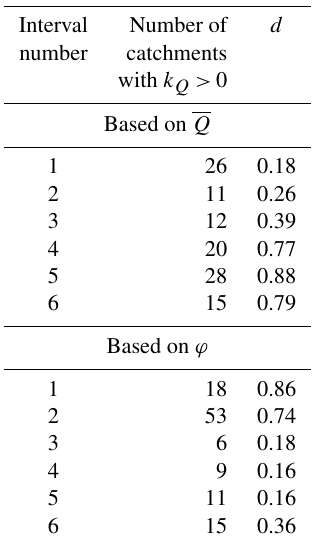
Figure 7. Comparison of estimated runoff trends k Q with observed trends k Q for (a) all catchments and (b) significant catchments. Sig- e nificant catchments are those experiencing significant changes in runoff at the significance level of 0.05. The error rate is defined as the proportion of catchments in which the signs of the observed and estimated trends differ. Table 2. Number of catchments with k Q > 0 and respective d in each interval based on Q and ϕ in the analysis of the observed trends. Interval numbers based on Q and ϕ are consistent with those in Table 1, as are the interval range and the sample size of each in- terval. d is the proportion of catchments becoming wetter in each